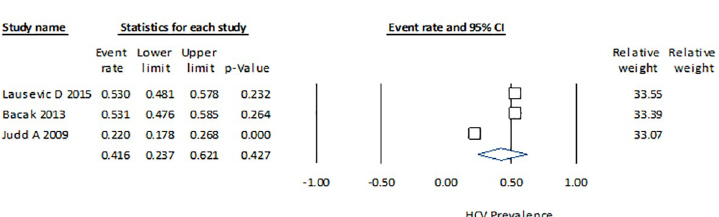
Fig 4. Forrest plot of random effects model to estimate HCV prevalence in IDU population in